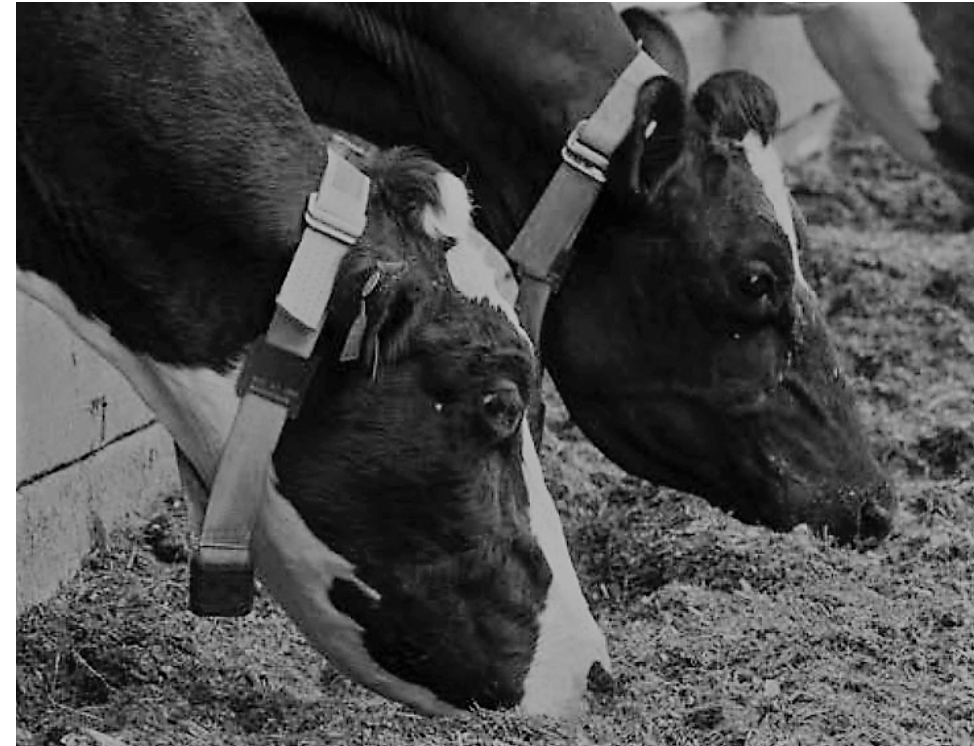
Figure 4. Activity collars on